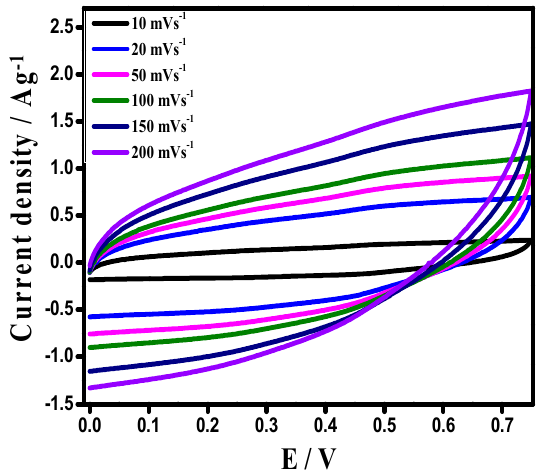
Figure 12. CVs of the device at different scan rates on best optimized potential window.